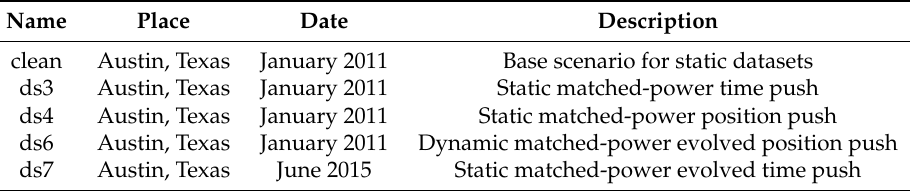
Table 1. Texas Spoofing Test Battery (TEXBAT) scenarios